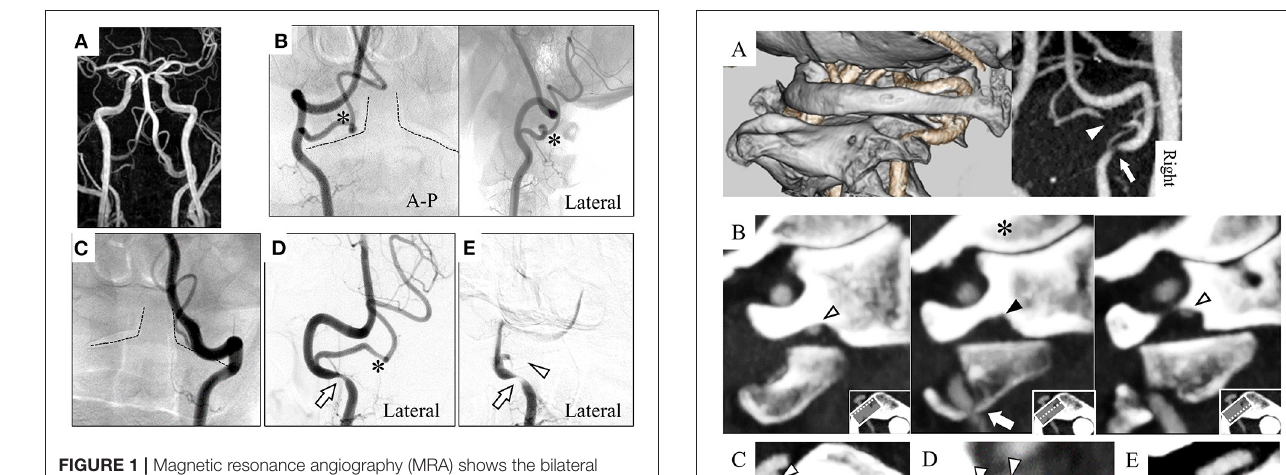
FIGURE 1 | Magnetic resonance angiography (MRA) shows the bilateral vertebral arteries (VAs) merging into the basilar artery, and the left VA is dominant (A) . Digital subtraction angiography (DSA) shows the right posterior inferior cerebellar artery (PICA) originating and coursing into the spinal canal between the atlas and the axis (B) . The left VA proceeds into the spinal canal at the atlas–axis level (C) . On dynamic DSA at 45 ◦ leftward head rotation (D) , the right VA was compressed at the V3 segment. At 60 ◦ leftward head rotation (E) , the right PICA becomes occluded in addition to severe compression of the right VA. Dotted line: trace of axis; *: right PICA; arrow: compressed right VA; arrowhead: occluded right PICA. A–P, anterior–posterior.